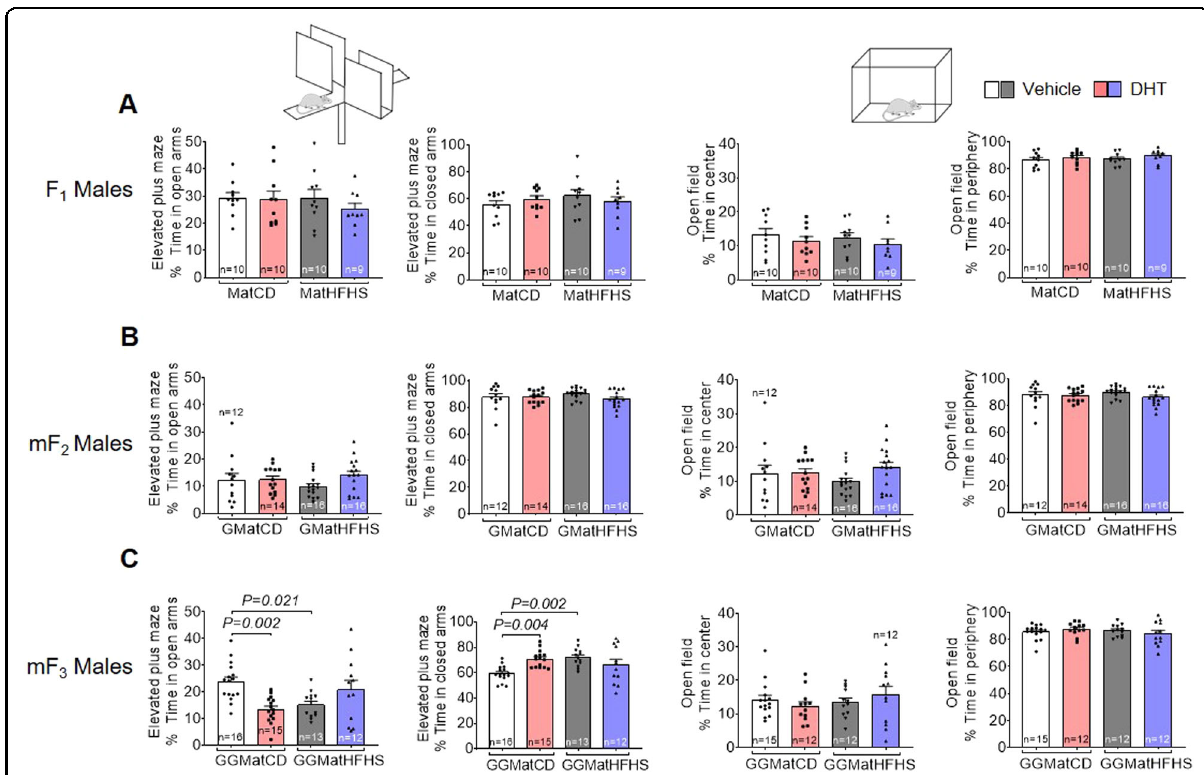
Fig. 3 Prenatal androgen exposure with and without maternal obesity causes transgenerational anxiety-like behavior in male offspring following the male germline. A – C Time spent in the open arms in the elevated plus maze; time spent in the closed arms of the elevated plus maze; time spent in the center of the open fi eld; time spent in the periphery of the open fi eld. F 1 – mF 3 : two-way ANOVA, Tukey ’ s post hoc analysis. All data are presented as mean ± s.e.m. DHT dihydrotestosterone; CD control diet, HFHS high-fat high-sugar, Mat maternal, GMat grand-maternal, GGMat great-grand maternal. The numbers of mice are stated in the bars of each = 14.93, maze in mF male offspring [open arms: F 3 1,52 = 12.35, P = 0.0009]. P = 0.0003] and [closed arms: F 1,52